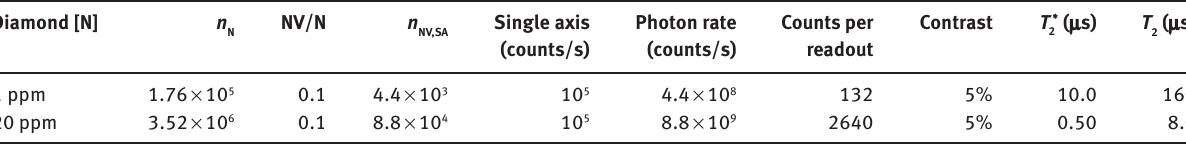
Table 1: Simulated diamond properties. Diamond [N] n